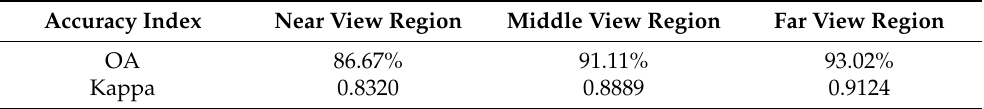
Table 8. Classification accuracy of Guanshaling.